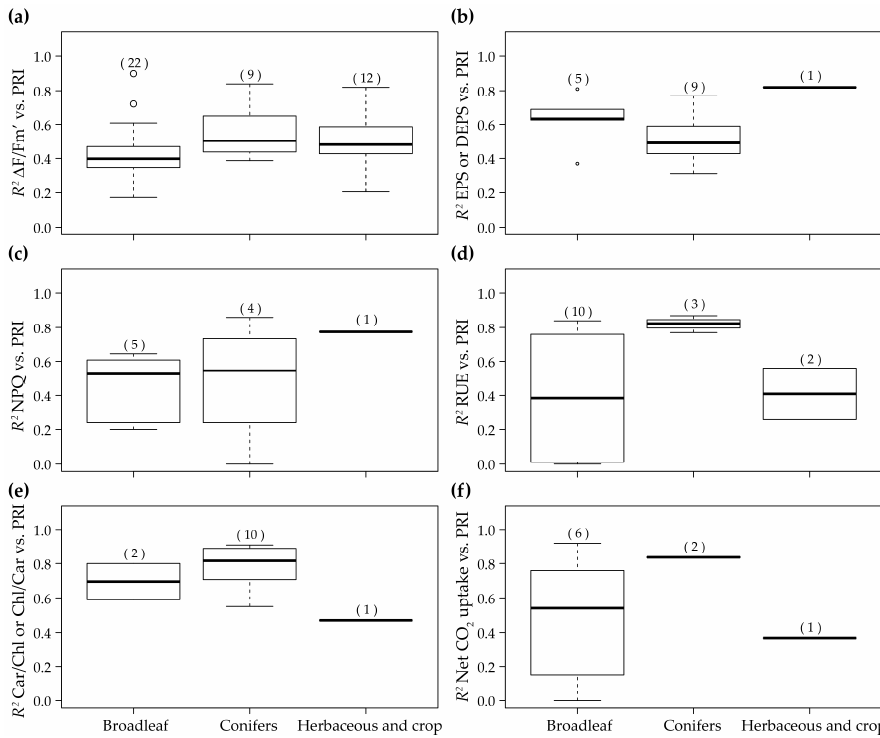
Figure 3. Boxplots of the coefficients of determination of the relationships between PRI and physiological variables at the foliar level and seasonal timescale: ( a ) Actual photochemical efficiency ( Δ F/Fm’); ( b ) Epoxidation or de-epoxidation state of xanthophylls (EPS or DEPS); ( c ) Non-photochemical quenching (NPQ); ( d ) Radiation-use efficiency (RUE); ( e ) Carotenoid/chlorophyll (Car/Chl) or chlorophyll/carotenoid (Chl/Car) ratio; and ( f ) Net CO 2 uptake. Central lines represent medians, boxes represent 50% of the data, whiskers represent minima and maxima and circles represent outliers. The numbers of correlations reported in the literature are shown in brackets. Remote Sens. 2016 , 8 , 677